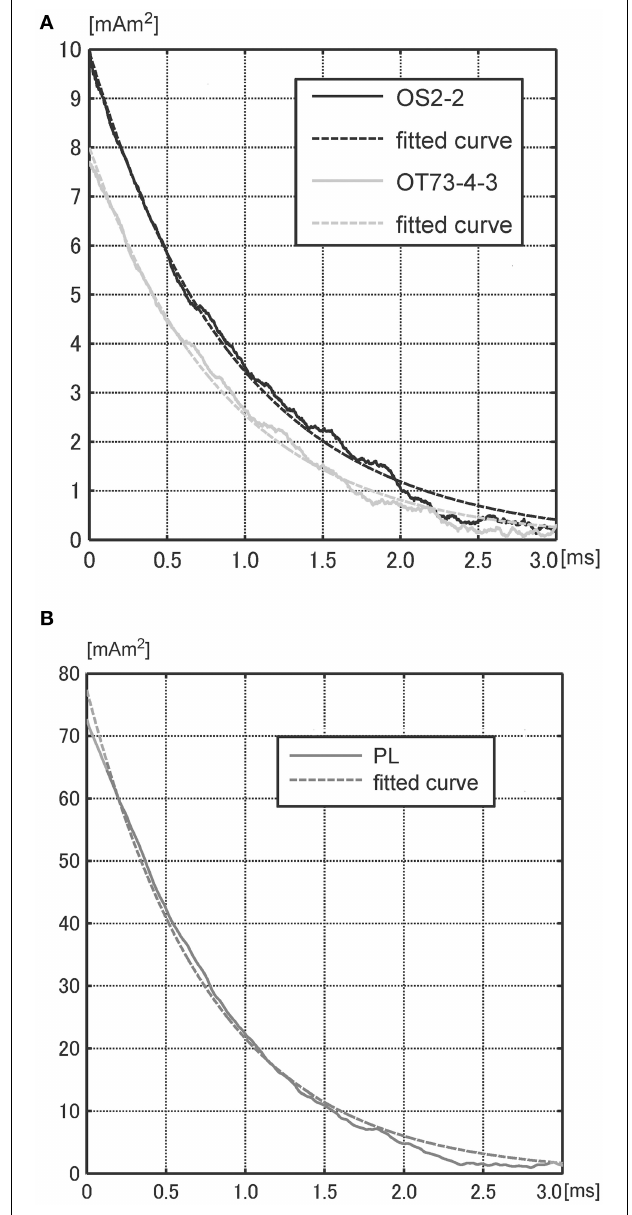
FIGURE 8 | Mean M–t curves (solid) and fitted exponential curves (dotted), focusing on to the short interval (3ms) after turning off a pulsed field. (A) sample OS2-2 and OT73-4-3. (B) sample